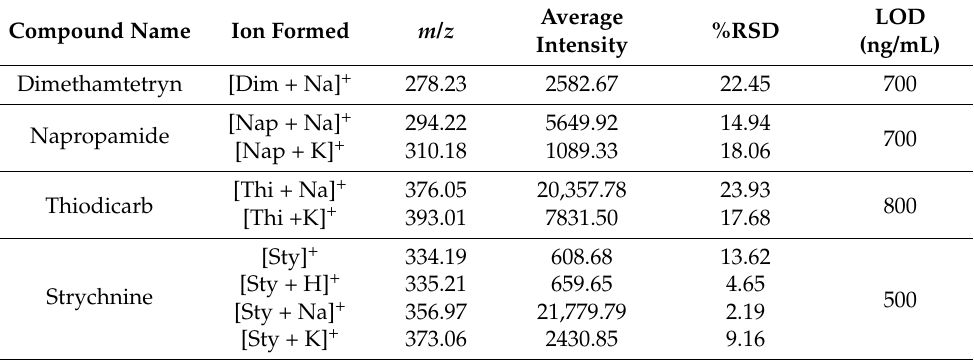
Table 3. Poisons detected, ion formed, m / z , average intensity, %RSD, and LOD in human